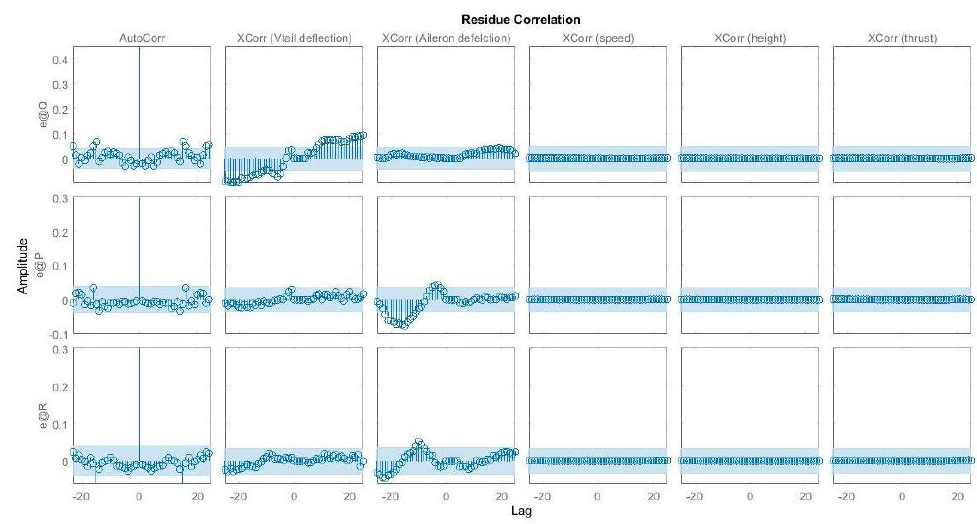
Figure 11. ARX Model Residue Correlation.